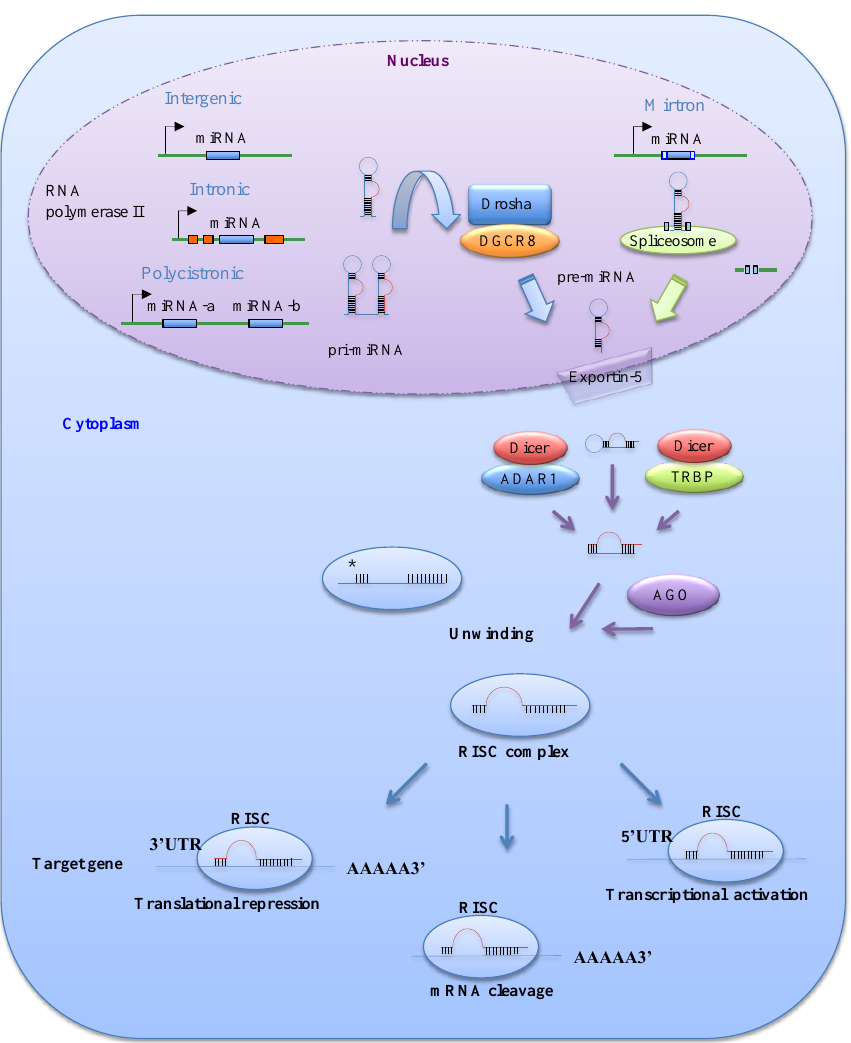
Figure 1. The biogenesis and function of microRNAs (miRNAs). MiRNAs are initially transcribed by RNA polymerase II or III as pri-miRNAs, which are processed into pre-miRNAs in the nucleus by Drosha-DGCR8. Precursor miRNAs (pre-miRNAs) can also be generated via the mirtron pathway. The products of pri-miRNA cleavage, the pre-miRNAs, are exported to the cytoplasm through exportin-5 and then cleaved in a complex comprising Dicer and transactivating response RNA-binding protein (TRBP) or adenosine deaminase acting on RNA 1 (ADAR1). The functional strand of a mature miRNA is incorporated into the RNA-induced silencing complex (RISC), which contains GW182 and AGO proteins. As a part of this complex, the mature miRNA modulates gene expression by binding to partially complementary sequences in the 3'UTRs or 5'UTRs of target mRNAs, leading to mRNA degradation, translational inhibition, or transcriptional activation.